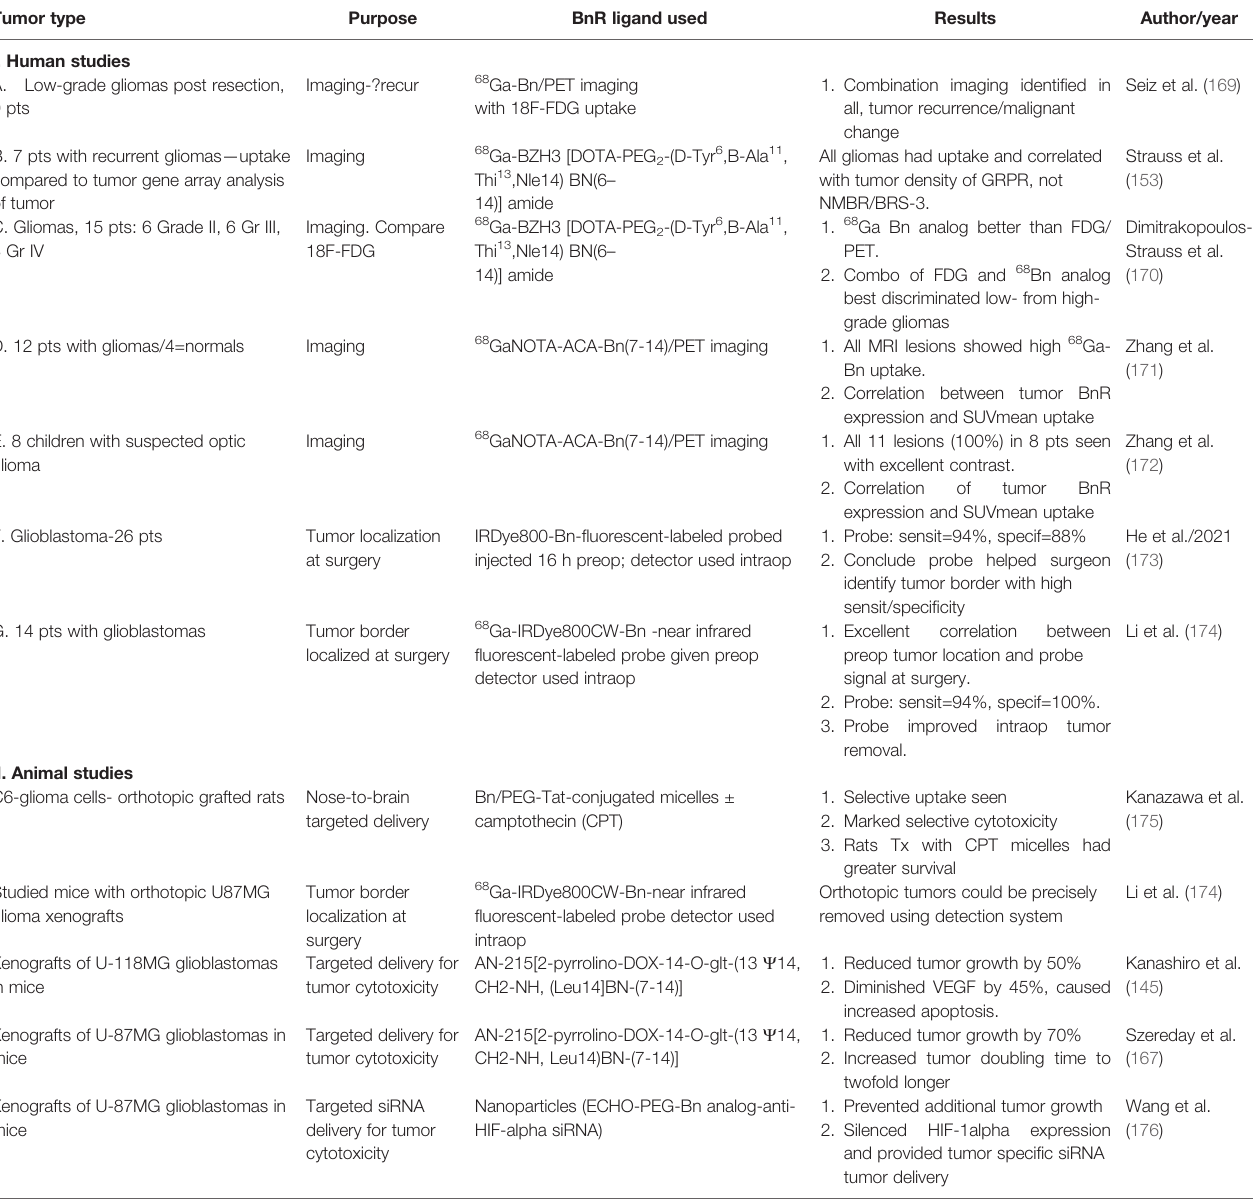
TABLE 1 | Summary of studies using BnR over-/ectopic expression by gliomas/glioblastomas for targeting for tumor imaging (identi fi cation of primary/tumor extent) or for possible targeting with cytotoxic